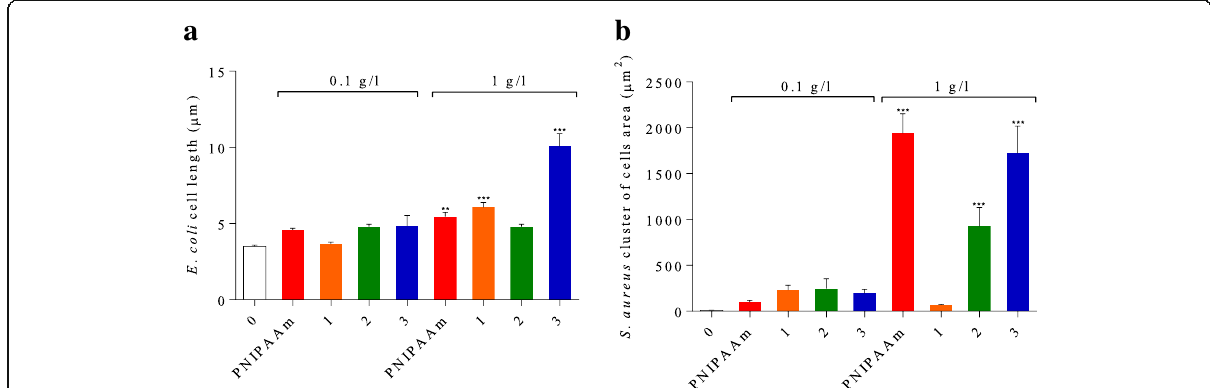
Fig. 7 Length of Escherichia coli cells ( a ) and area of cluster of Staphylococcus aureus cells ( b ) after 24-h incubation with PNIPAAm and (1) Fe 3 O 4 -